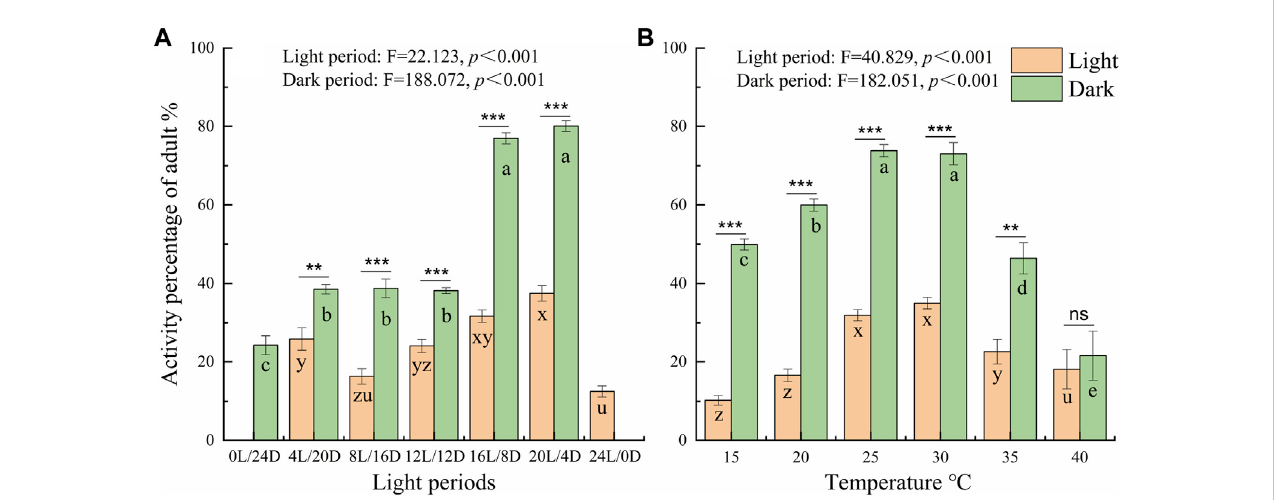
Figure 4 Comparison ofthelocomotoractivepercentagesof D.helophoroides betweenthelightanddarkphasesunderdifferentLDcycles (A) andtemperatures (B) . The difference in active percentage between the light and dark phases under the different conditions was determined by two-tailed Student ’ s t tests (*** p < 0.001, ** p < 0.01). a, b, and c indicate signi fi cant differences in the active percentages of during the dark phase at different temperatures according to Duncan ’ s post hoc test, one-way analysis of variance ( α = 0.05). x, y, and z indicate signi fi cant differences in the active percentage during the light phase at different temperatures according to Duncan ’ s post hoc test, one-way analysis of variance ( α = 0.05). Data shown are the mean ± SEM (n =